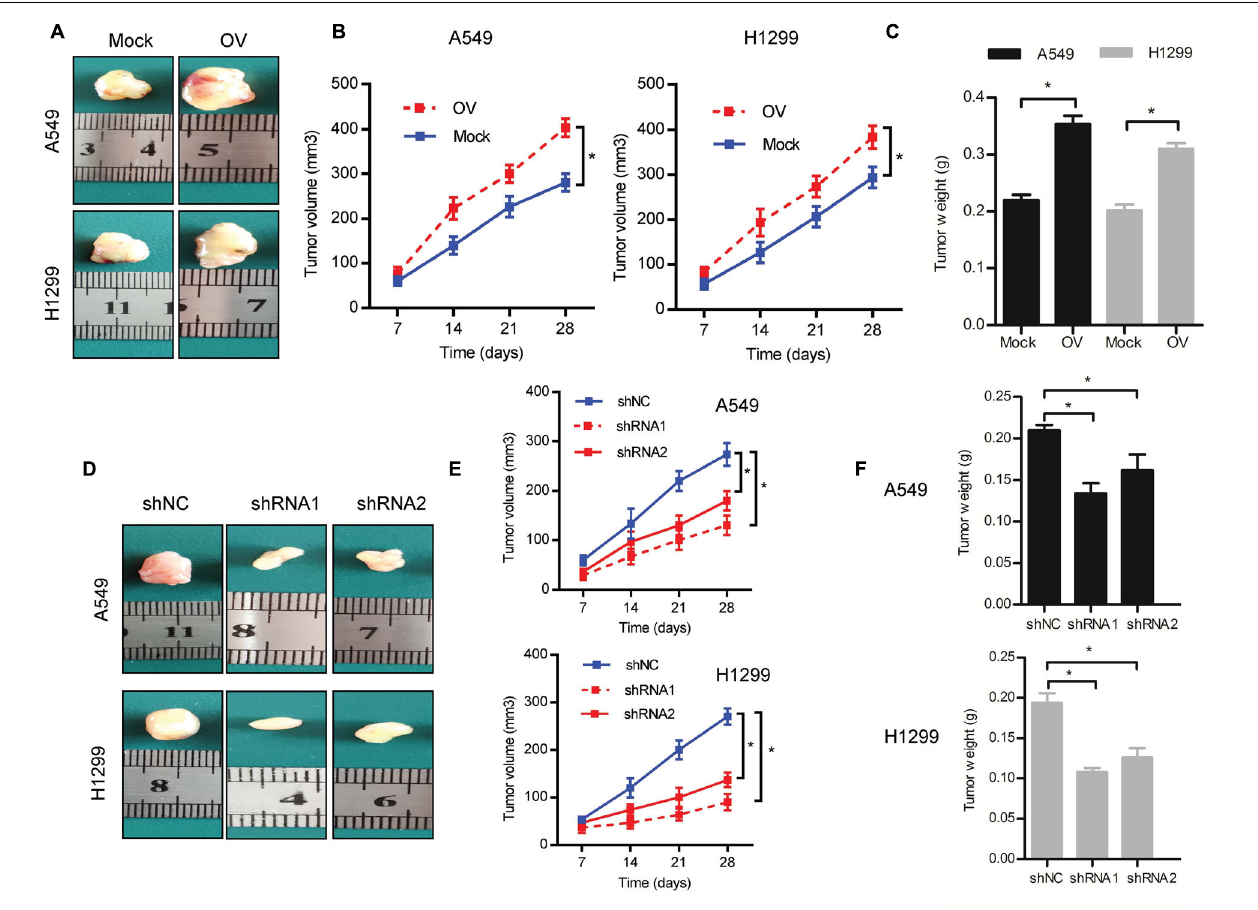
FIGURE 4 | C1GALT1 promotes LUAD tumor growth in vivo . (A) Representative images of excised tumors from nude mice injected with C1GALT1-overexpressing cells. (B,C) Analysis of tumor volume (B) and weight (C) after C1GALT1 overexpression. (D) Representative images of excised tumors from nude mice injected with C1GALT1-knockdown cells. (E,F) Analysis of tumor volume (E) and weight (F) after C1GALT1 knockdown. n = 3 mice per group. Mock, cells transfected with empty plasmid; OV, cells transfected with C1GALT1 overexpression plasmid; shNC, cells infected with negative control shRNA; shRNAs, cells infected with C1GALT1 shRNA. Data are expressed as mean ± SD. * p <